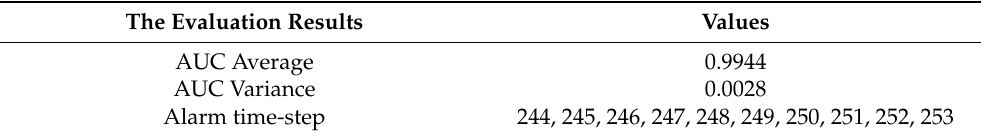
Table 5. M-iForest model evaluation results and malfunction alarm time-step of the second type of degradation